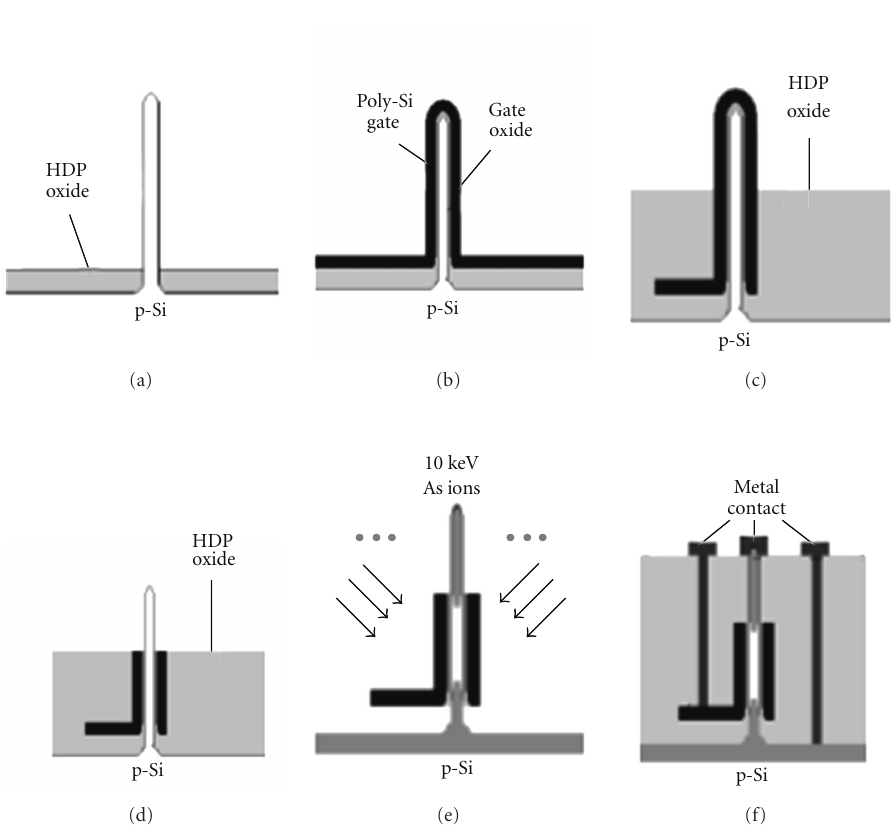
Figure 2: (a) Single silicon nanowire with bottom isolation, (b) after gate stack deposition, (c) after gate extension pad definition and HDP oxide deposition followed by etch back defining gate length, (d) after poly-silicon end cap removal, (e) removal of oxide followed by S/D and gate implant (single implant for all three electrodes), (f) final device after metalization. (Reprinted with permission from [15]. [2008] IEEE.)